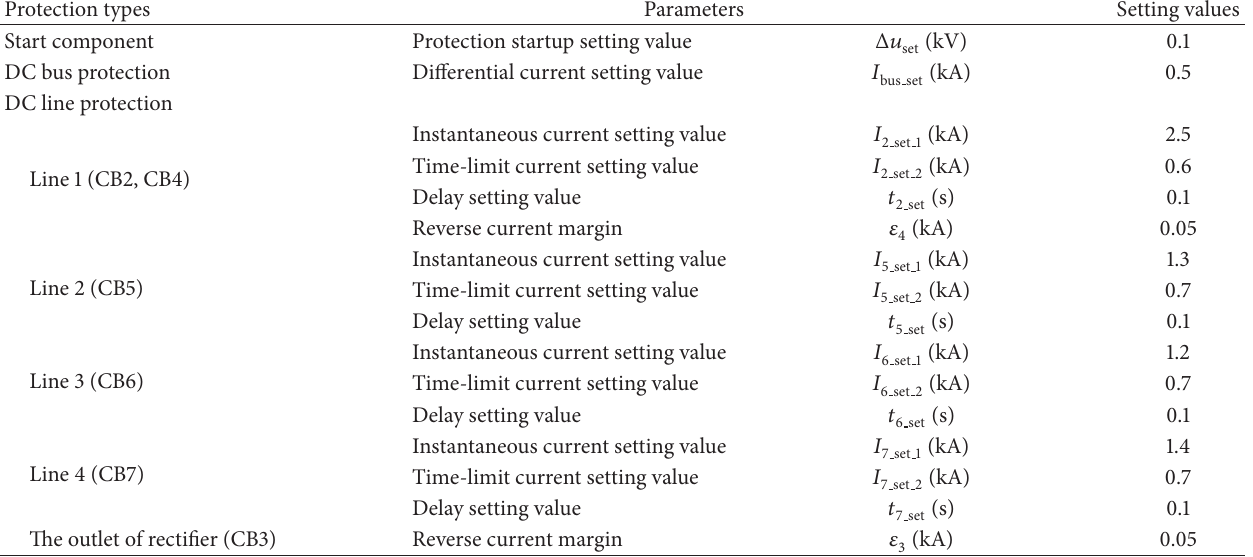
Table 2: The setting values of parameters (sampling frequency of protection device: